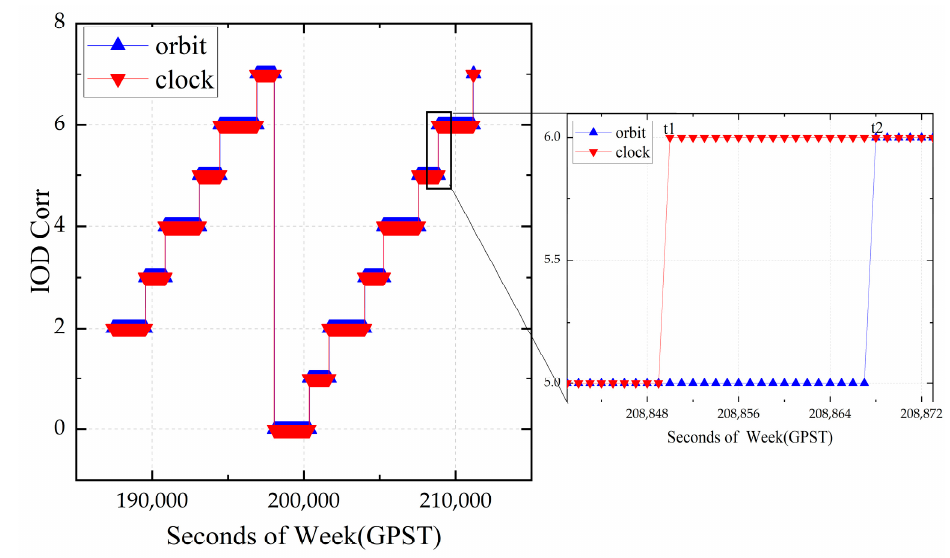
Figure 1. Take time b as reference to update IOD Corr (C23, 8 March 2022).